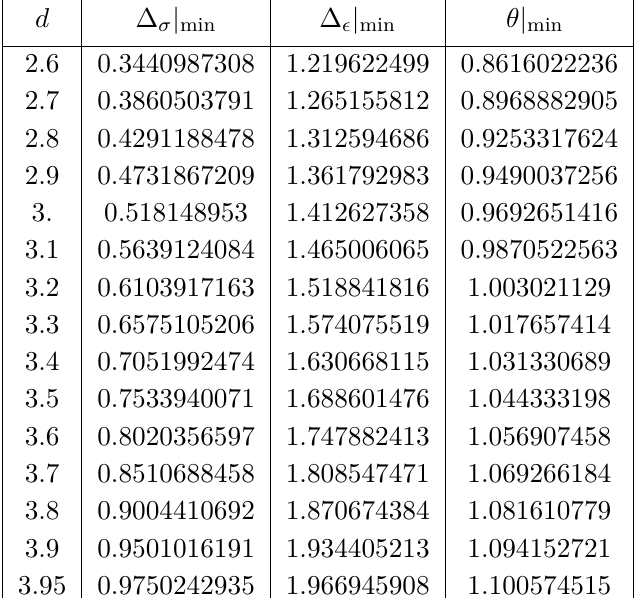
Table 6 . Table of navigator minima.